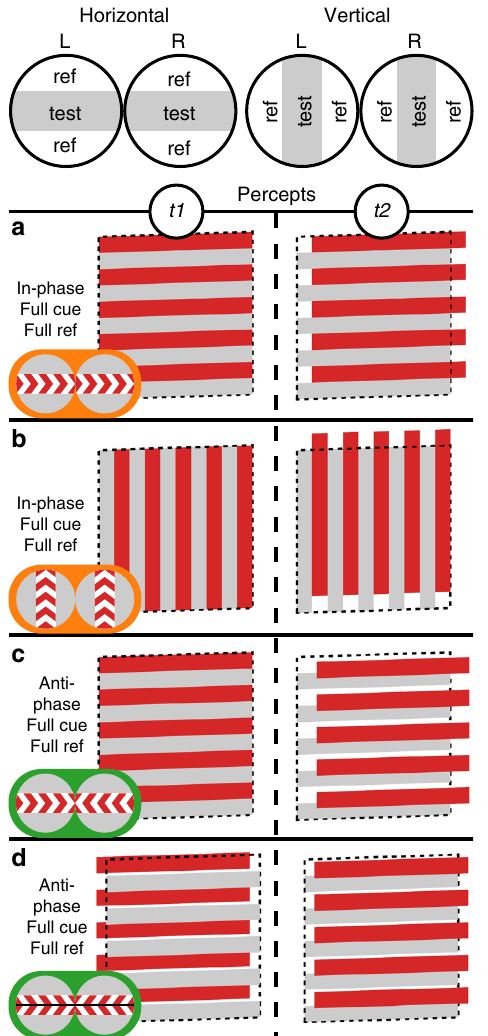
Fig. 1 Schematic of the stimulus con fi gurations. The displays were random- dot kinematograms with alternating test and reference bands (20 of each in the actual display, 5 shown here). Dots in test bands moved coherently either in-phase between the two eyes ( a , b ) or in anti-phase ( c , d ). In the reference bands, dots were either static, uncorrelated between the eyes, or removed completely, depending on the experiment and condition (see Fig. 2). Here we show FOUR conditions, each with static reference dots and each represented with an icon depicting the moving test bands as a central band with fl anking reference bands. An illustration of the corresponding percept is shown next to each icon: Both horizontal ( a ) and vertical ( b ) in-phase motion gives rise to movement in the plane, while horizontal anti-phase motion means that the display will alternate between 0 and crossed horizontal disparity, giving rise to movement in depth ( c ). Vertical anti-phase motion alternates between 0 and left-hypo disparity, and does not give rise to movement in depth. The endpoints of the monocular apparent motion trajectories can be manipulated such that the horizontal motion will generate a display that alternates between equal and opposite values of crossed and uncrossed disparity, still giving rise to movement in depth ( d ). The vertical equivalent of this display alternated between left-hyper and left-hypo disparity, not giving rise to movement in depth. In addition to these schematics, videos of the actual displays are included as Supplementary Movies 1 – References are crucial for both in-phase motion and anti-phase motion . The SSVEP related to both absolute (unreferenced) and relative (referenced) in-phase motion occurs at even harmonics of the stimulus frequency, with the second harmonic response